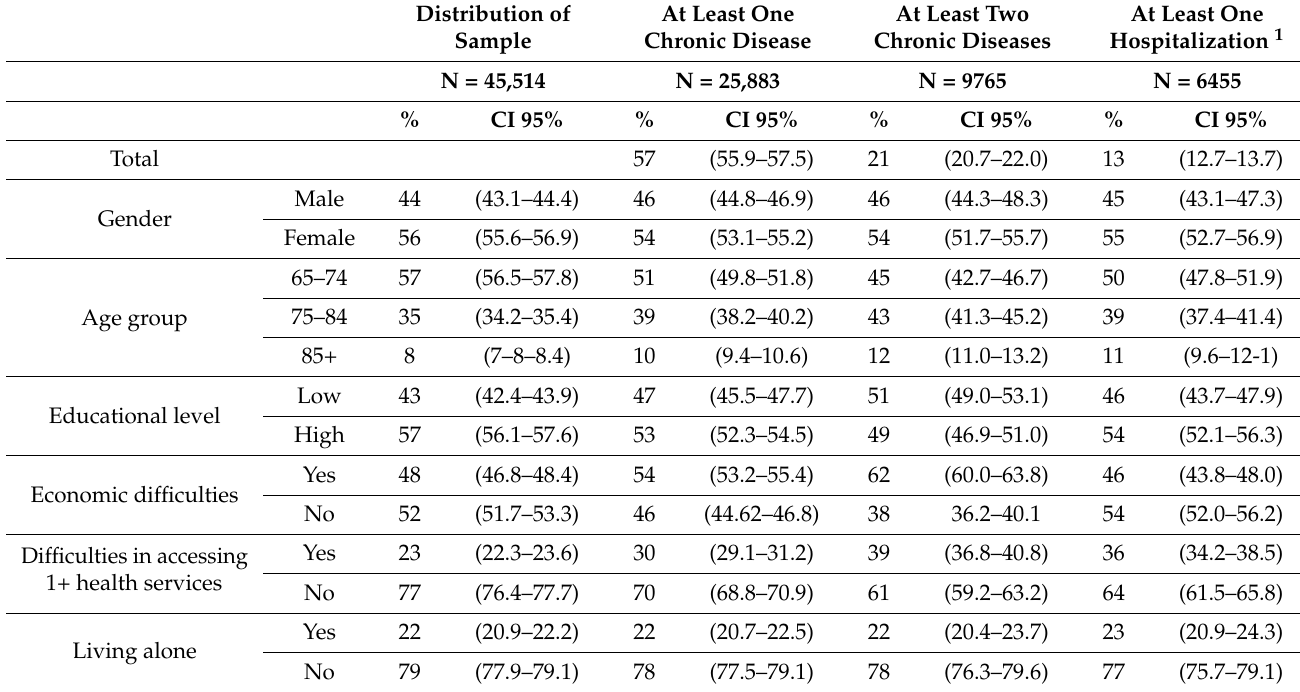
Table 1. Sociodemographic and health characteristics of elderly: overall, by presence of chronic diseases and hospitalization and relative confidence intervals at 95% (95% CI). Passi d’Argento, 2016–2019 ( n = 45,514 out of